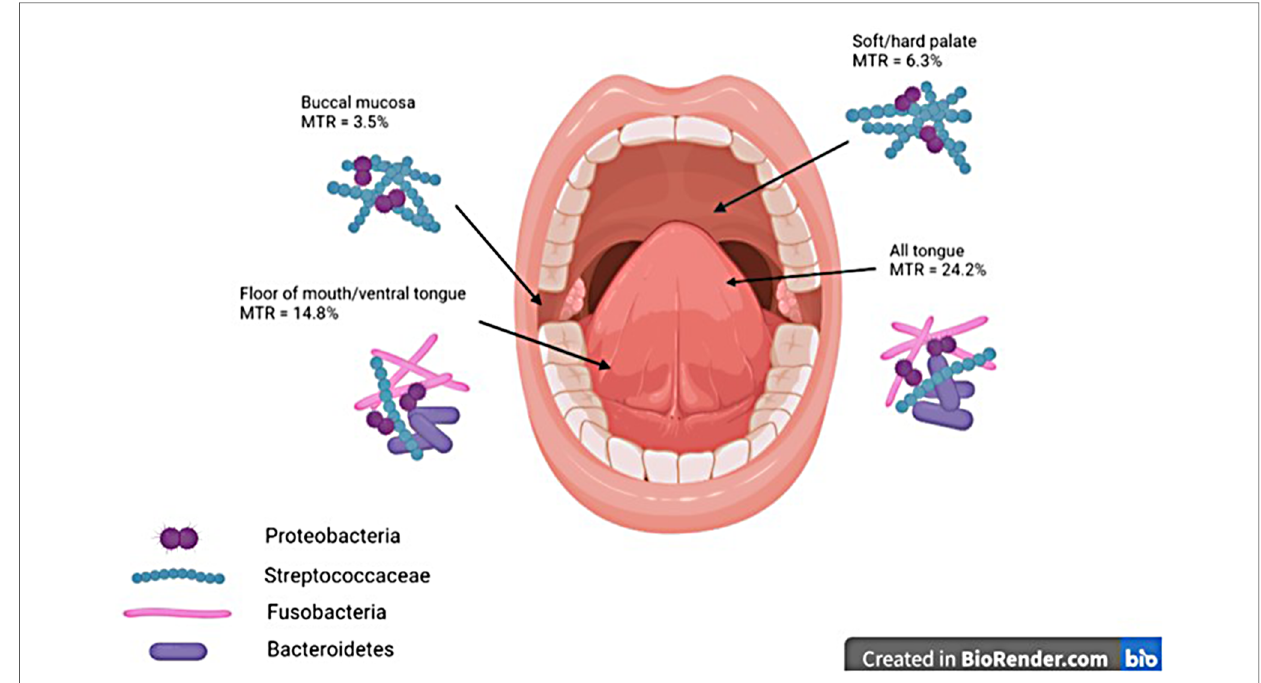
FIGURE 1 Graphic demonstrating MTRs at different oral mucosal sites and dominant taxonomic groups of bacteria at each site. MTRs, malignant transformation